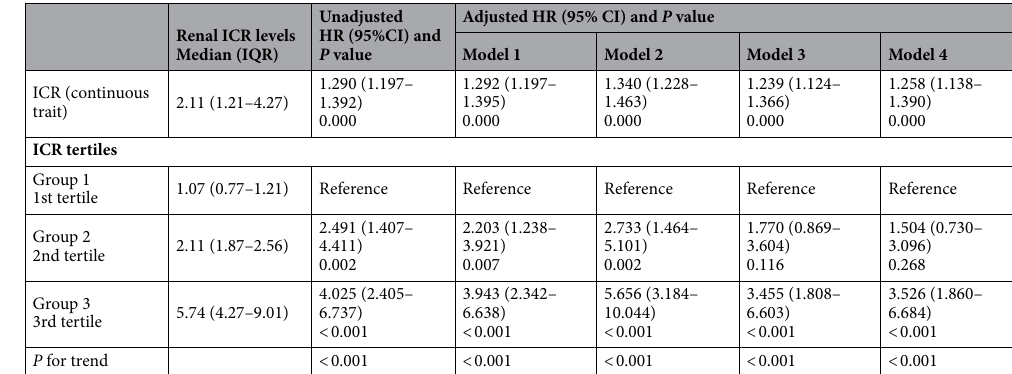
Table 2. Associations of renal ICR level with disease progression in IgA nephropathy patients. Model 1 adjusted for sex (analyzed as dichotomous data) and age. Model 2 adjusted for covariates in model 1 plus estimated glomerular filtration rate, proteinuria, and mean arterial pressure. Model 3 adjusted for covariates in model 2 plus Oxford MEST-C score. Model 4 adjusted for covariates in model 3 plus steroids or other immunosuppressive agents (yes or no, analyzed as dichotomous data). The disease progression event was defined as end-stage renal disease or ≥ 40% decline in estimated glomerular filtration rate. P values for trends were calculated by entering the median value of each tertile of renal ICR level as a continuous variable. IQR interquartile range, HR hazard ratio, CI confidence